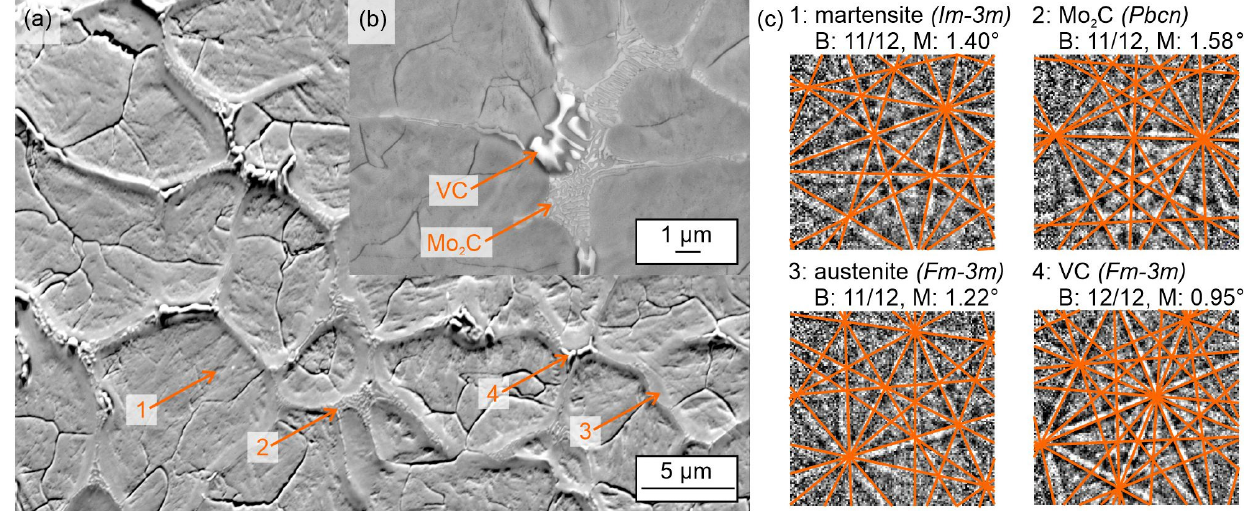
Figure 1. SEM images of the deep etched Fe85Cr4Mo8V2C1 steel processed by: ( a ) laser powder bed fusion (BD: building direction); ( b ) centrifugal casting; and ( c ) gravity casting. The carbide network is marked by arrows.